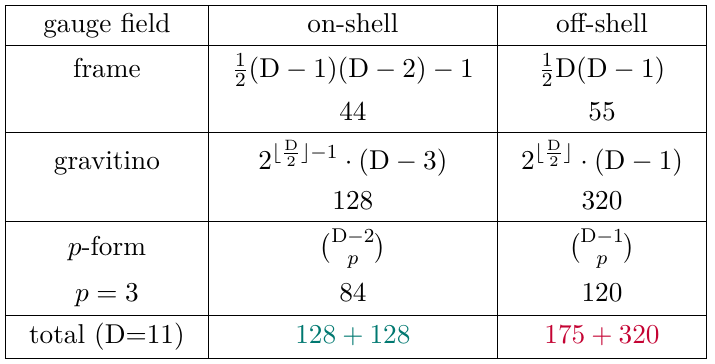
Table 1 . Counting of degrees of freedom in D dimensions relevant to Poincaré supergravity. (For conformal supergravity, some (gamma-)traces should be